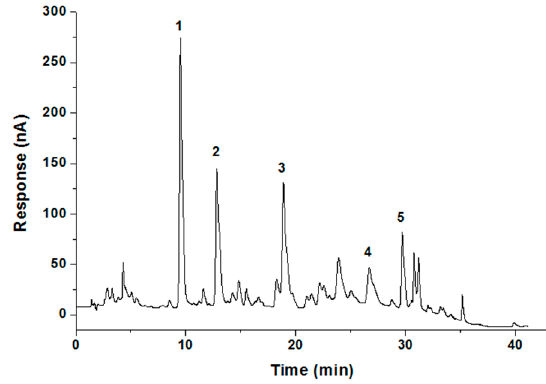
Figure 5. HPLC chromatograms of the KSP components (column, 150 mm × 4.6 mm, 5 μ m; flow rate, 1.0 mL/min; eluent, methanol-water system; ECD voltage, 0.8 V). The peaks were identified as protocatechuic acid (1); p -hydroxybenzoic acid (2); caffeic acid (3); p -coumaric acid (4) and ferulic acid (5). Table 4. Determination of the five polyphenolic compounds in the kiwifruit seeds a . Compounds